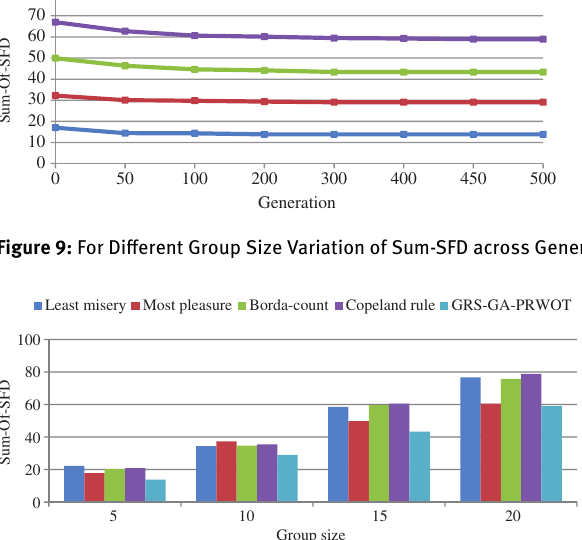
Figure 10: The Effectiveness of Proposed GRS-GA-PRWOT for Different Group Sizes Compared with Several Techniques. Experiment 3. Here, the effectiveness of the group recommendation by our proposed Scheme GRS-GA-PRWOT is compared with baseline techniques based on mean nDCG with varying group sizes. Results are shown in Figure 11.